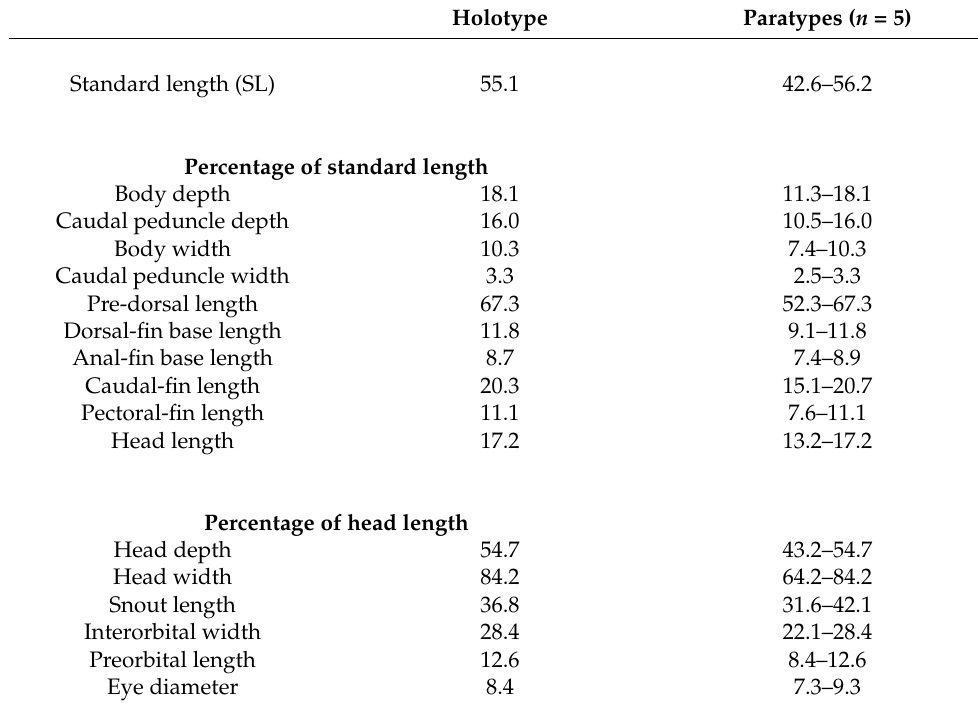
Table 2. Morphometric data of Trichomycterus listruroides Costa, Katz & Azevedo-Santos sp.